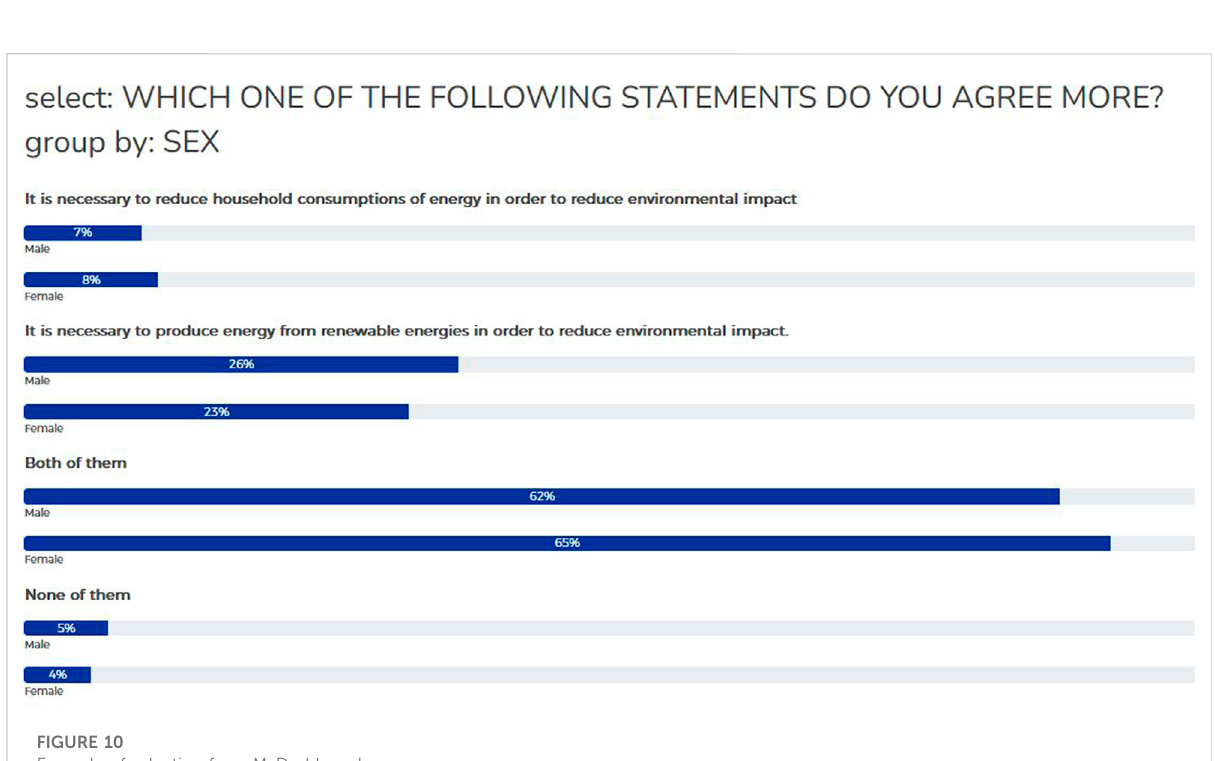
FIGURE 10 Example of selection from